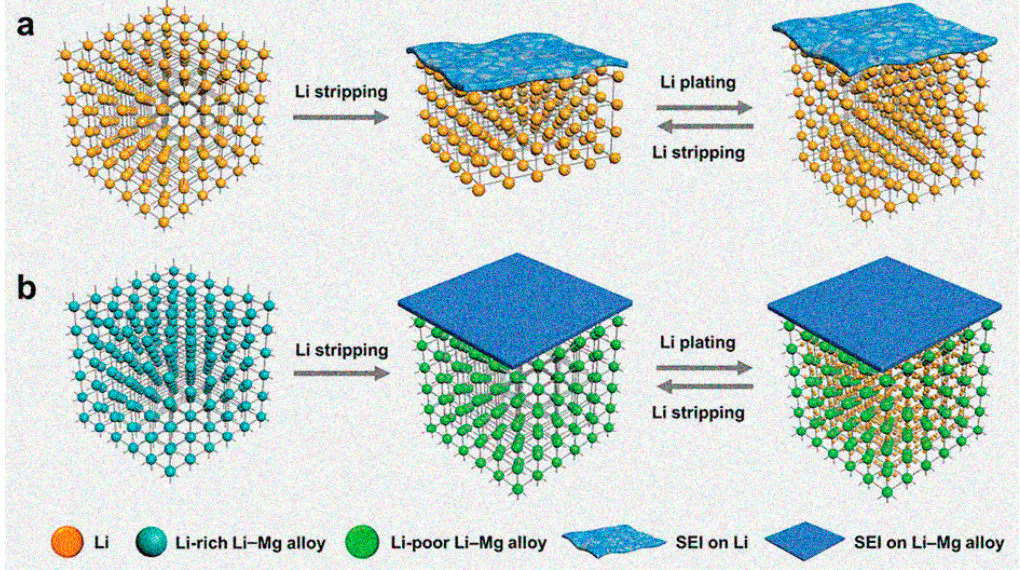
Figure 9. Schematic structure illustration in the bulk and at the surface for ( a ) Li and ( b ) Li - Mg alloy anodes during Li stripping/plating process.